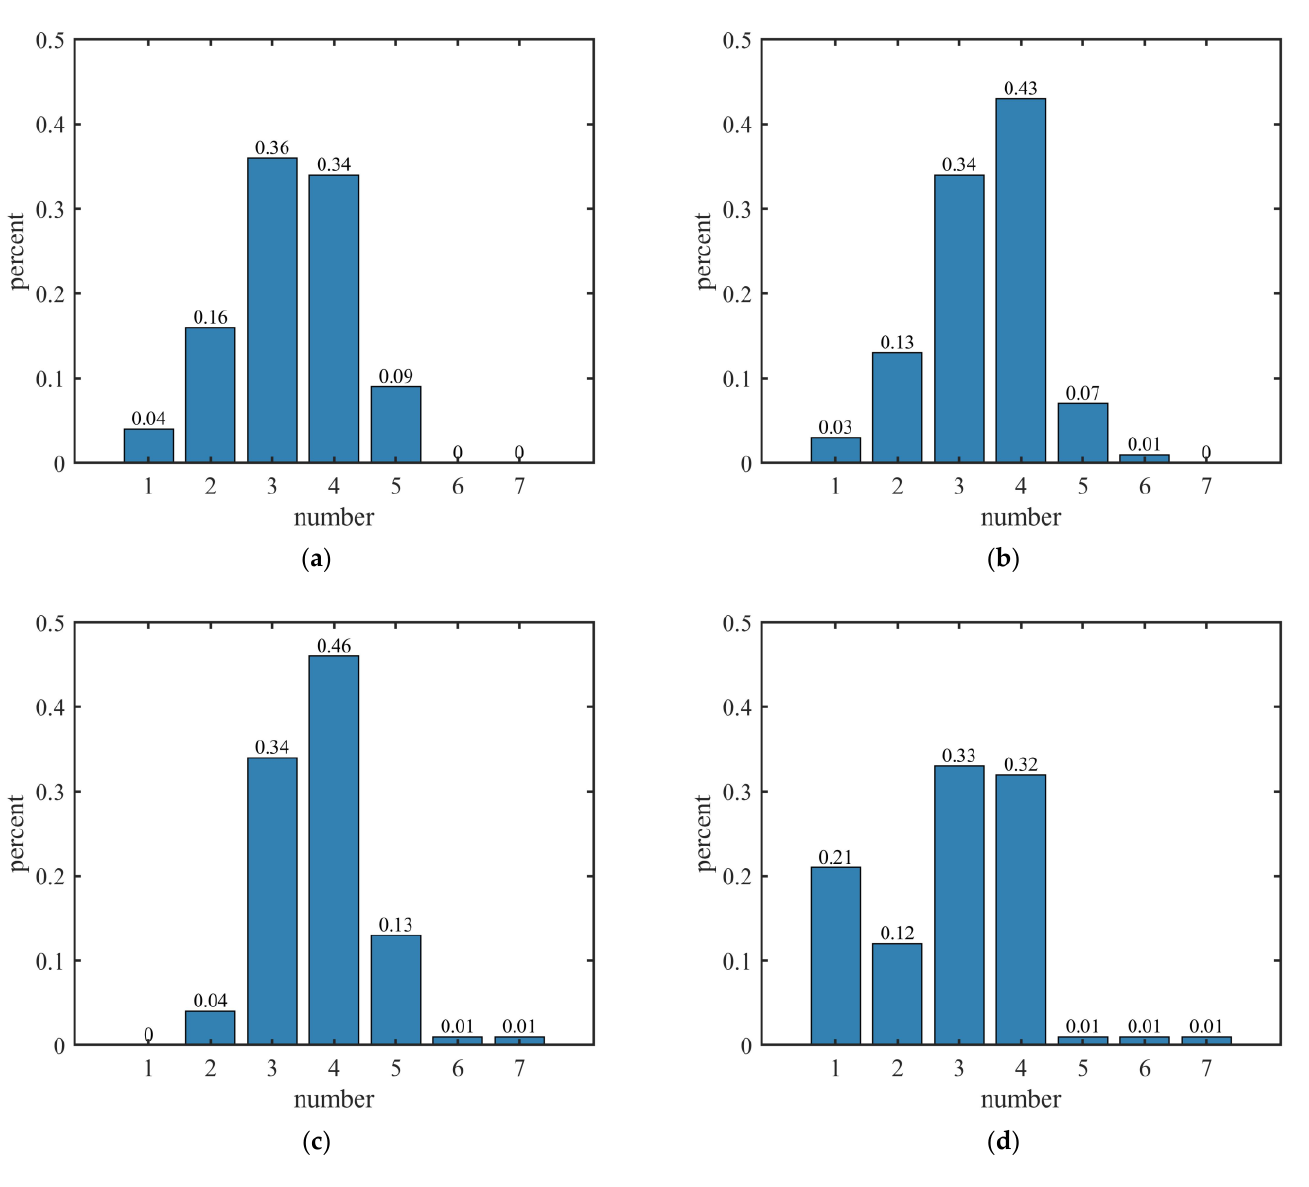
Figure 6. Quantitative distribution of source number: ( a ) quantitative distribution of source number employing two modes, including original signal and mode 1; ( b ) quantitative distribution of source number employing three modes, including original signal, mode 1, and mode 2; ( c ) quantitative distribution of source number employing four modes, including original signal, mode 1, mode 2, and mode 3 ; ( d ) quantitative distribution of source number without multimodal fusion.